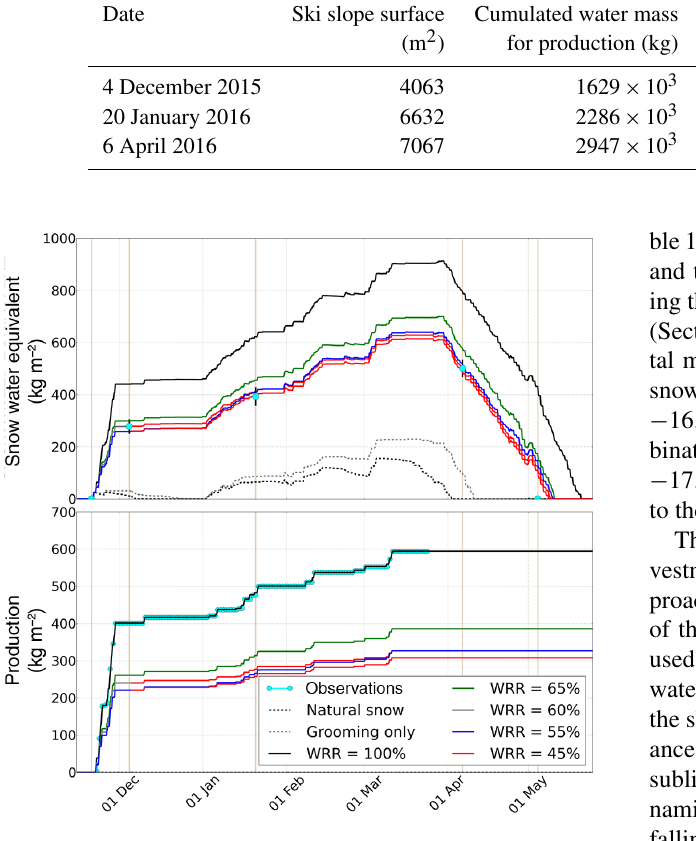
Figure 8. Seasonal evolution of the ski slope snowpack. Simula- tions of natural snow and groomed natural snow conditions are shown along with simulations of the ski slope conditions including MM snow production, accounting for water recovery rates (WRR) of 100%, 65% and the three combinations (Table 10) which pro- vided the best agreement with the observations (dots with error